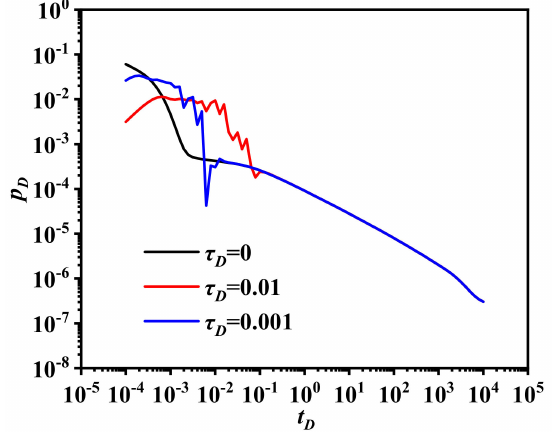
Figure 6. Effect of lagged time on well rate.